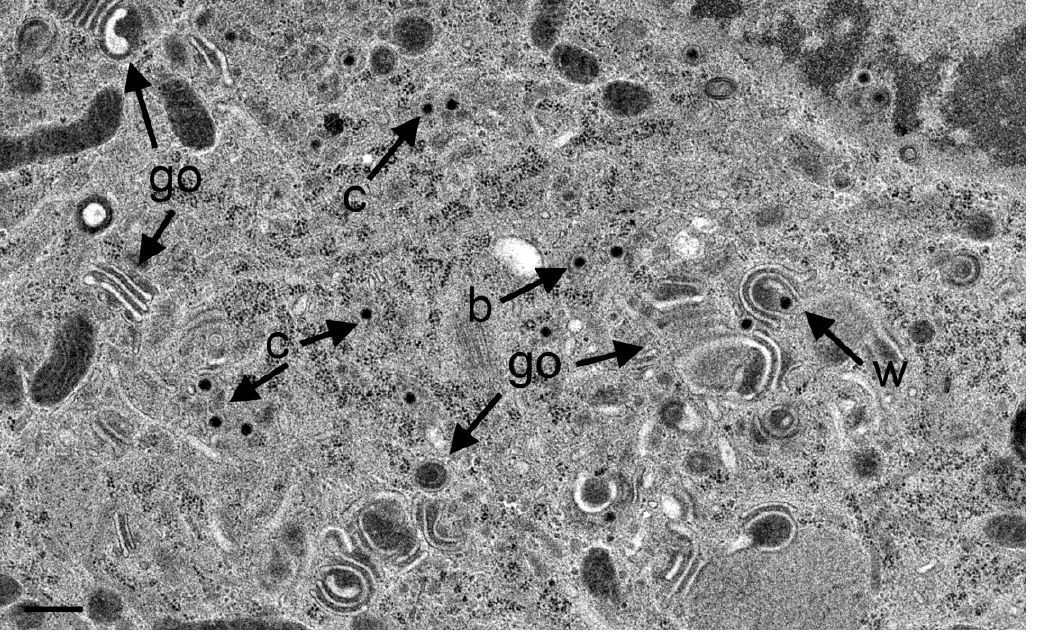
Figure 10. TEM images at 20 hpi with R7041(∆U S 3) showing an area with at least 13 capsids (c), multiple Golgi stacks (go) containing thick electron dense membranes, and a capsid in the process of wrapping (w) that results in a malformed virion. One capsids bud (b) at a membrane that cannot be identified. Bar = 500